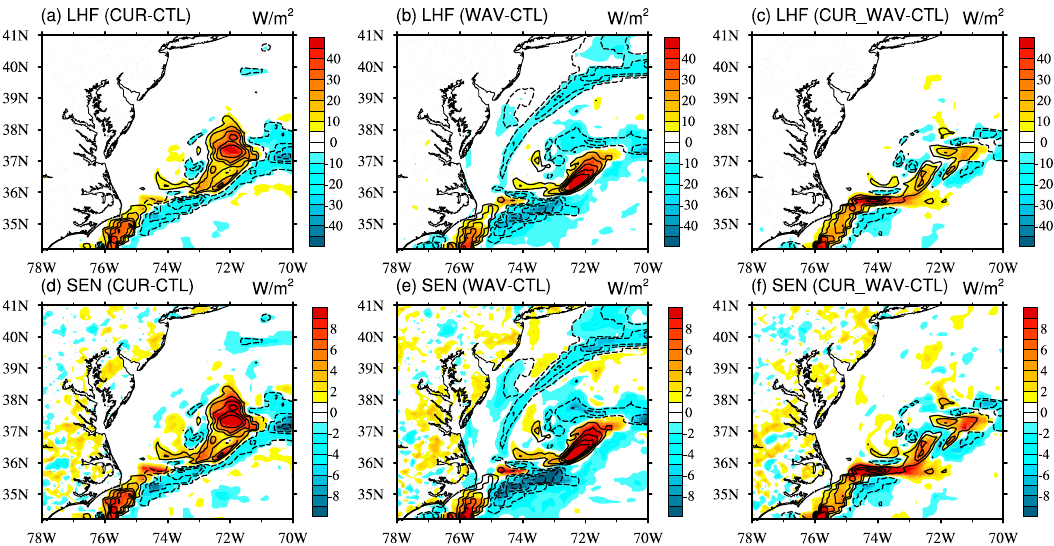
Figure 10. The 30 day averaged ( a – c ) latent heat flux and ( d – f ) sensible heat flux (color shade, W/m2) change for CUR, WAV, and CUR_WAV experiments. Contours overlaid in ( a – f ) are the corresponding differential SST, with solid and dashed contours (contour interval = 0.2 °C) corresponding to positive and negative values, respectively.